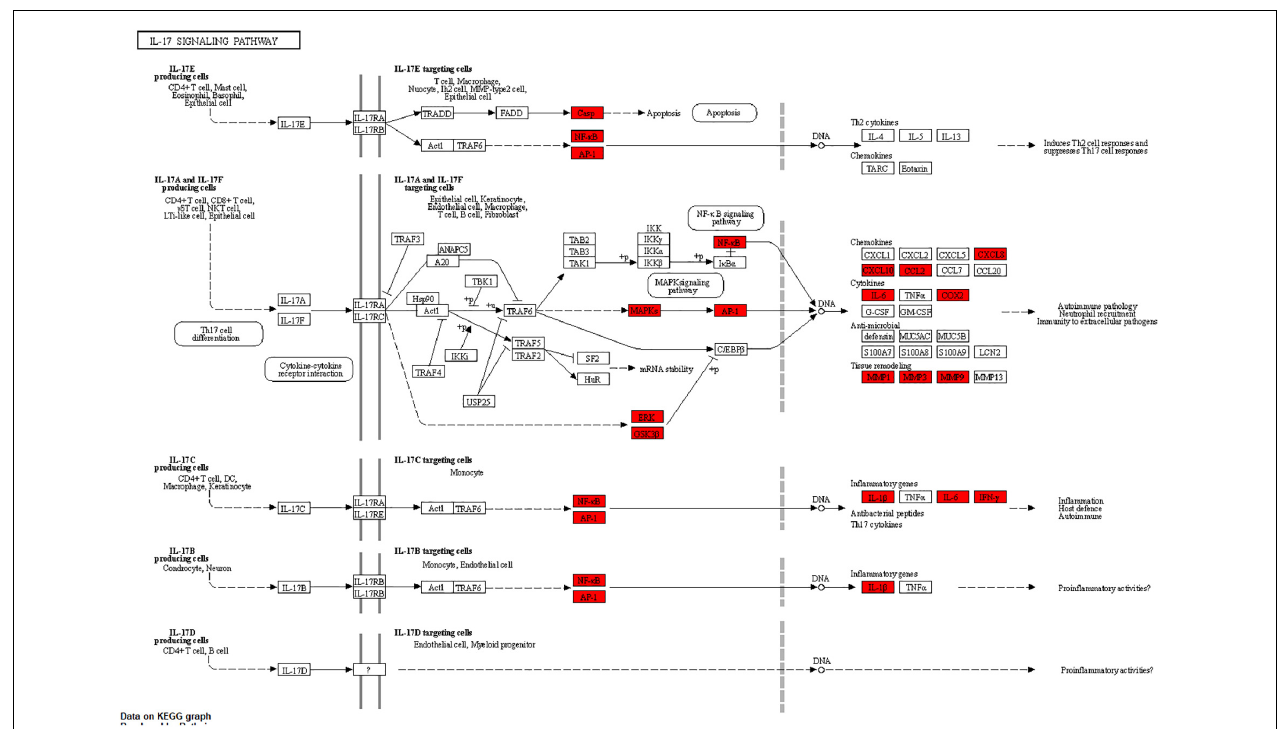
FIGURE 8 | The IL-17 signaling